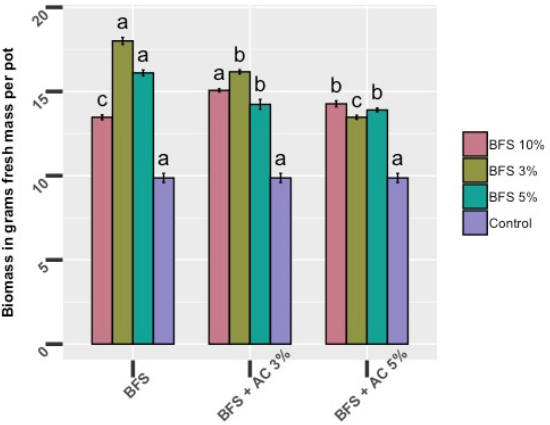
Figure 4. Amount of resulting biomass of Lolium perenne L. using different concentrations of Blast Furnace Slag (BFS) and Activated Carbon (AC).